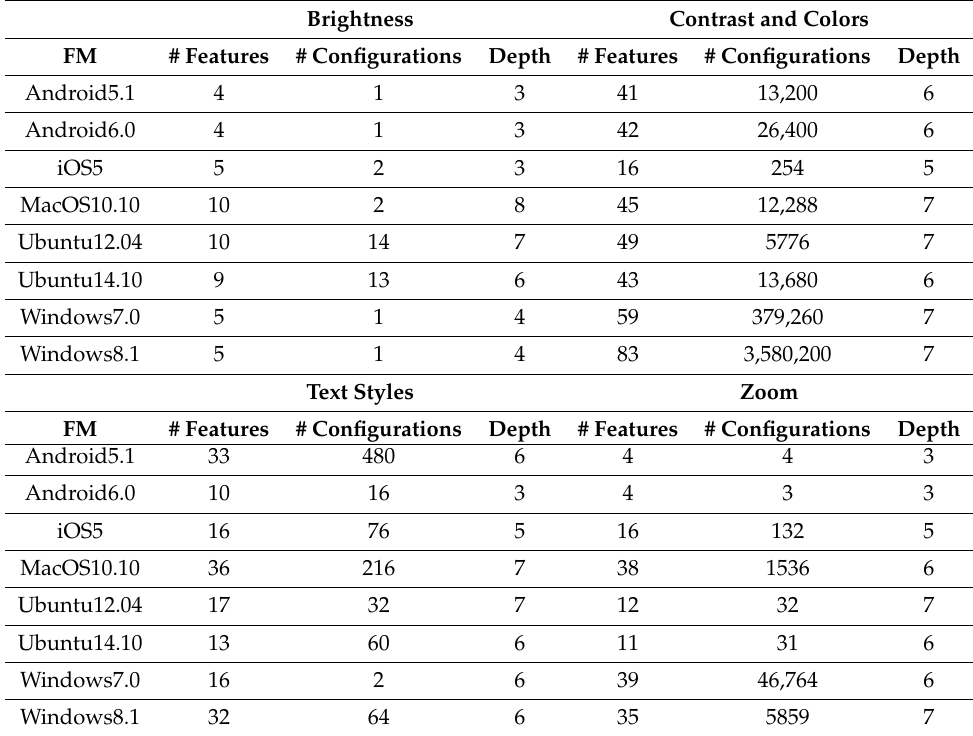
Table 9. Metrics on the FMs.